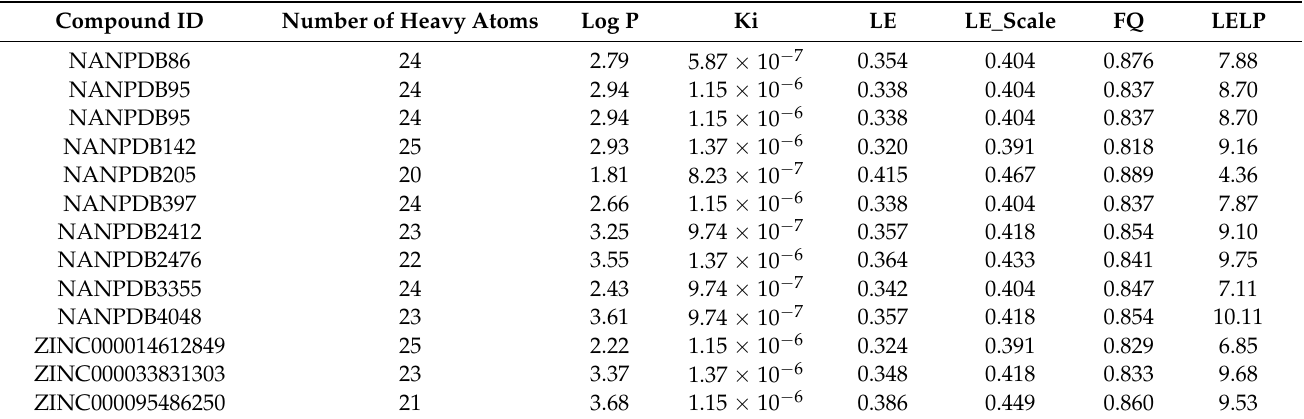
Table 6. The Ligand metrics used to evaluate the quality of the selected compounds, namely ligand efficiency (LE), fit quality (FQ), LE_scale, LE-dependent lipophilicity (LELP) and inhibitory constant (Ki). Compound ID Number of Heavy